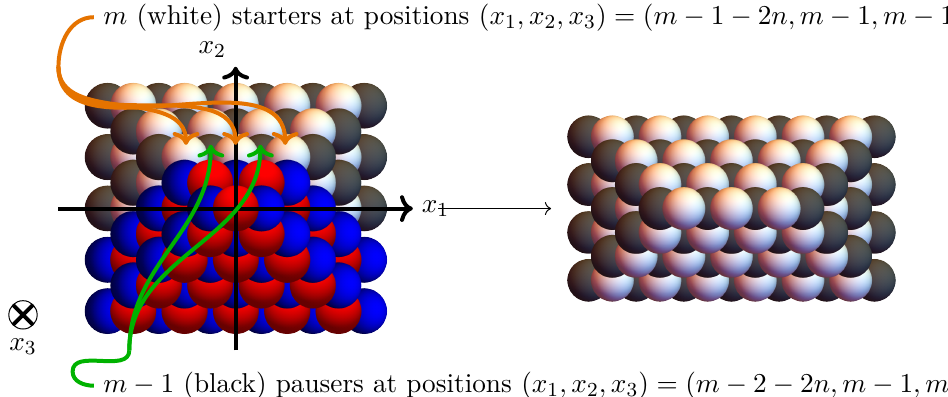
Figure 14 . The subcrystal for the infinite chamber C ( i ) m can be obtained from the canonical crystal by removing m − 1 double layers of atoms. Left: canonical crystal C C 0 = C ( i ) 1 slices of atoms marked (red for color 1 and blue for color 2 ). Right: removing the red and blue atoms gives the subcrystal for the infinite chamber C ( i )